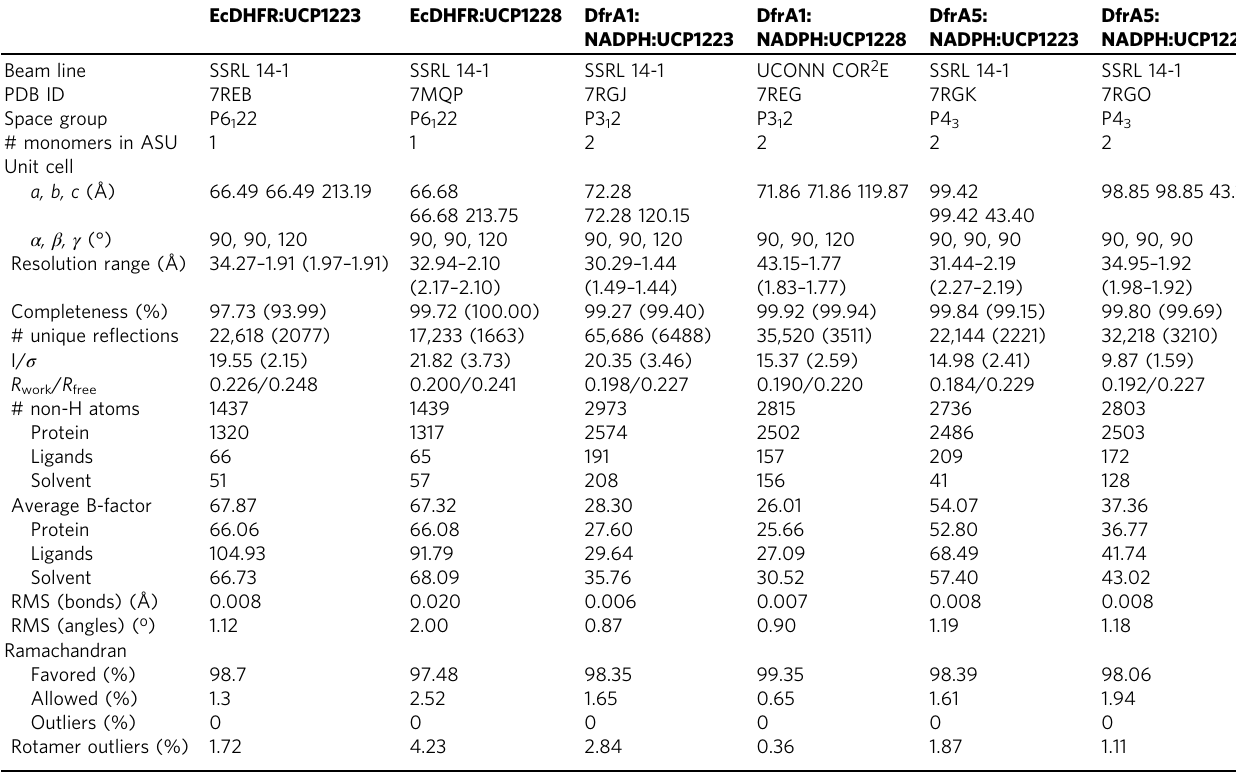
Values in parentheses are for highest-resolution